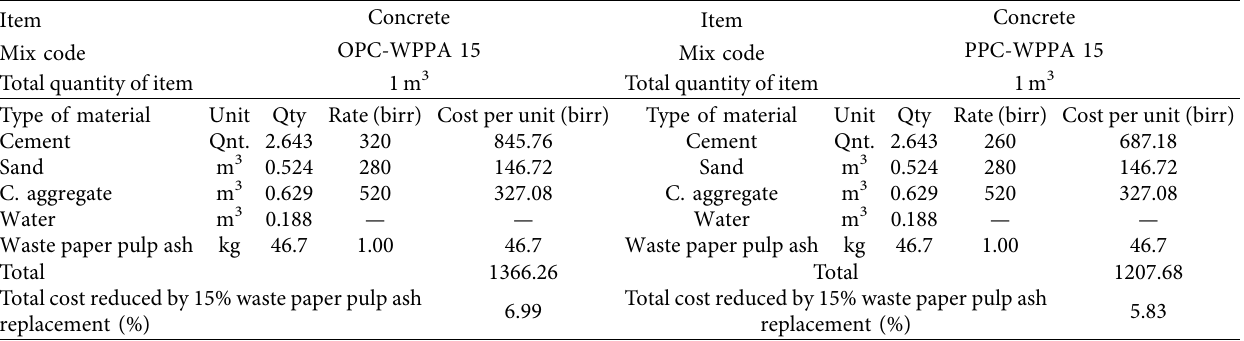
Table 19: OPC-WPPA 15 and